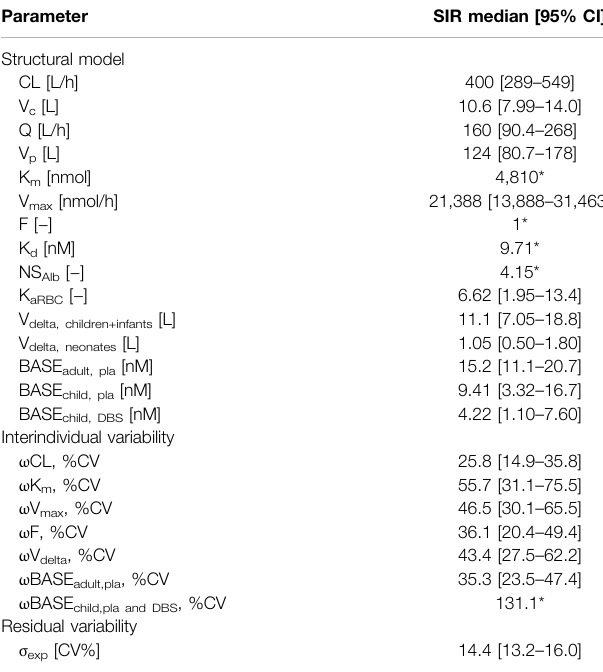
TABLE 1 | Parameter estimates with sampling importance resampling (SIR) median and 95% con fi dence intervals (CI) of developed cortisol pharmacokinetic(PK)modelincludingadultplasmadataandpediatricplasmaand dried blood spot (DBS)